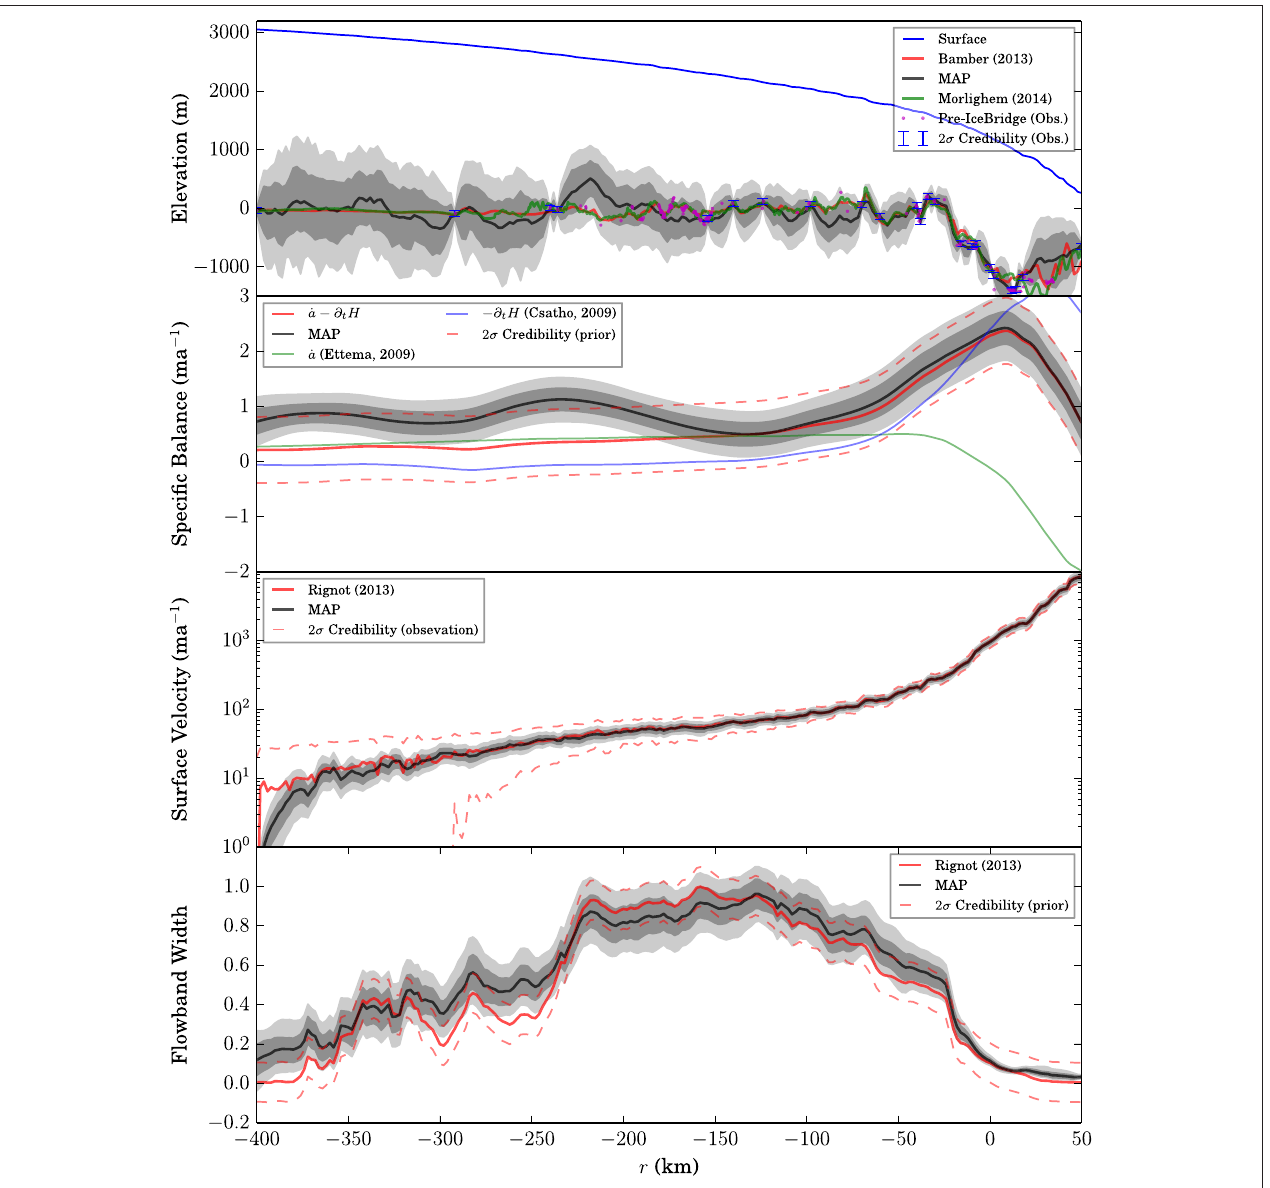
FIGURE 6 | Recovered pointwise probability densities for a flowband over Jakobshavn Isbræ. Dark and light gray shaded regions indicate the σ and 2 σ posterior credibility interval, respectively. Also included are the digital elevation models of Bamber et al. (2013) and Morlighem et al. (2014a), as well as pre-Icebridge radar observations that were not included in the solution procedure (Allen et al.,